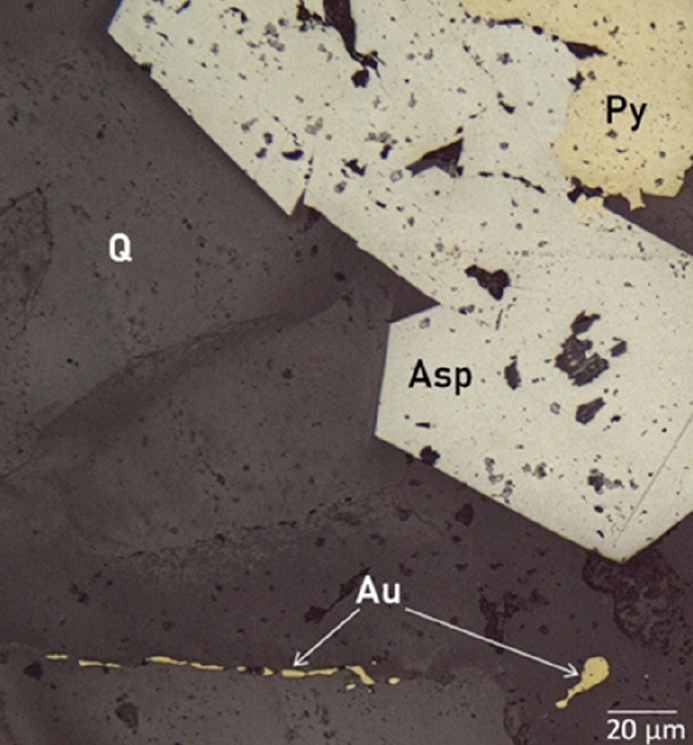
Figure 2. Native gold confined to cracks in quartz (sample 86–147.8). Q—quartz, Asp—arsenopyrite, Py—Pyrite, Au—gold.